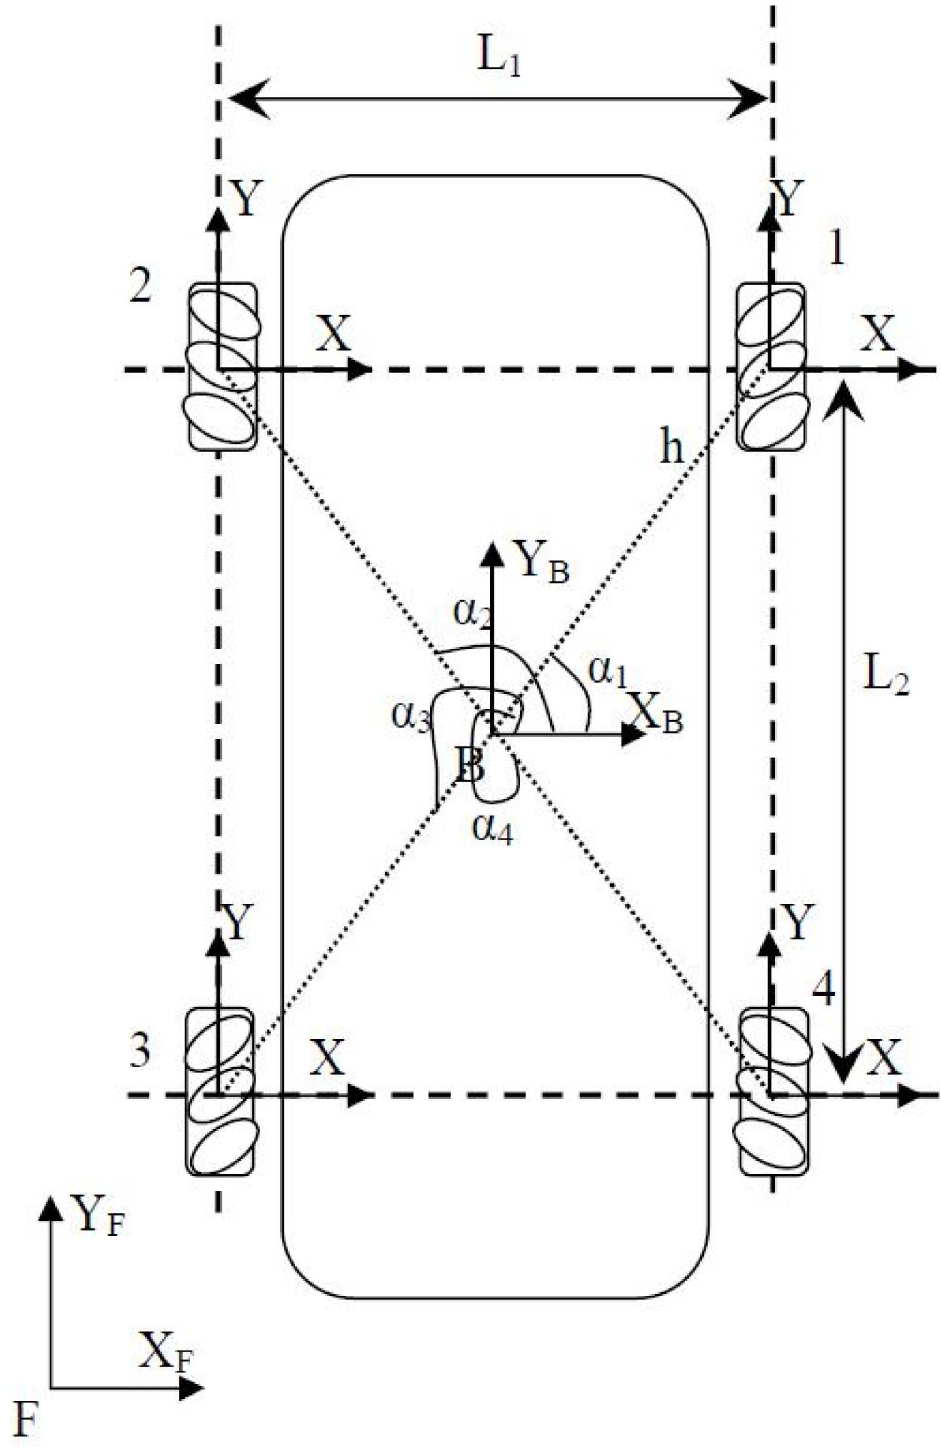
Fig 1. The Wheeled Chair